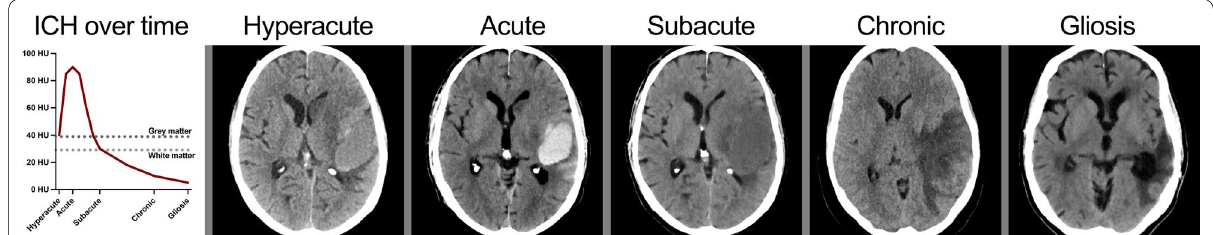
Fig. 1 Hematoma attenuation. The left panel illustrates the changes in hematoma attenuation over time. In the hyperacute phase, within the first minutes of onset, the hematoma is iso-attenuating with gray matter. Within an hour, the attenuation in the hematoma increases to the hyperattenuating typical appearance of the acute phase, lasting for several hours. The attenuation then gradually decreases over the next days to iso-attenuating with the gray or white matter in the subacute phase, and then even further to become hypoattenuating in the chronic phase, typically within weeks of onset. Finally, the hematoma is absorbed and the lesion is healed with substance loss and gliosis in the surrounding